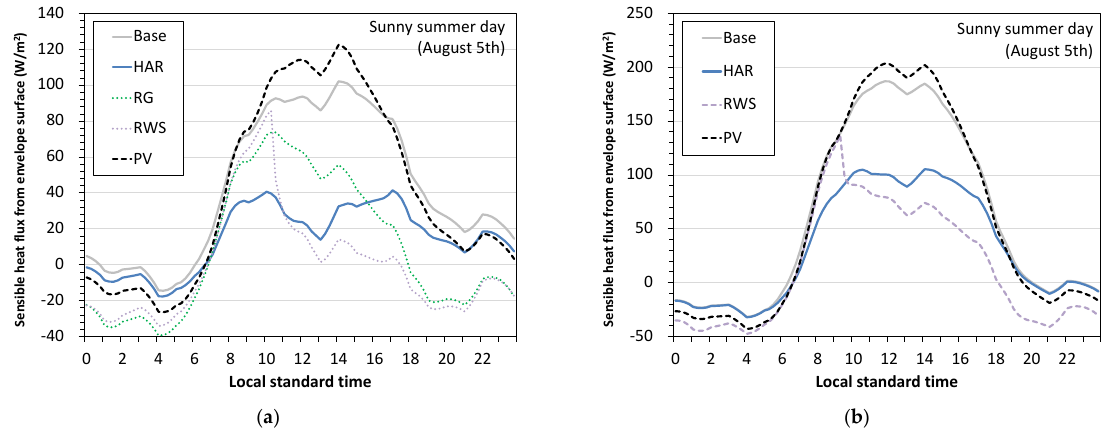
Figure 6. Time series of the sensible heat release from an envelope surface on a representative sunny summer day for ( a ) reinforced concrete structure and ( b ) wooden structure with low insulation level.